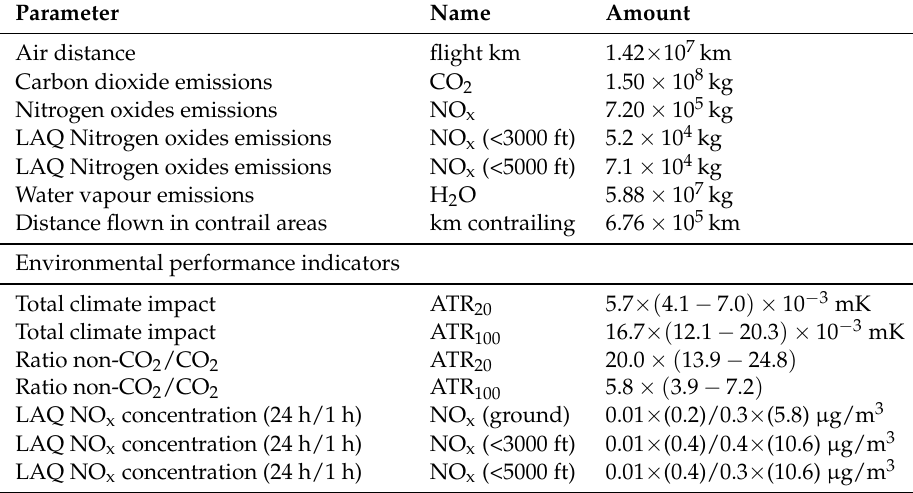
Table 1. Performance Parameter of European traffic sample: Cumulated emissions and distance in contrail areas on 18 December 2015. For climate impact uncertainty range is provided in parenthesis. For local air quality concentrations (LAQ) mean values together with maximum values n parenthesis are provided, on an daily and hourly (24 h/1 h)